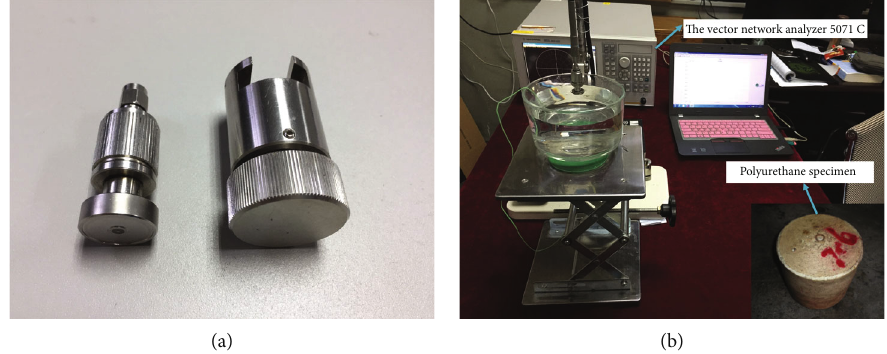
Figure 5: The dielectric permittivity experiment. (a) High temperature probes. (b) Instrument